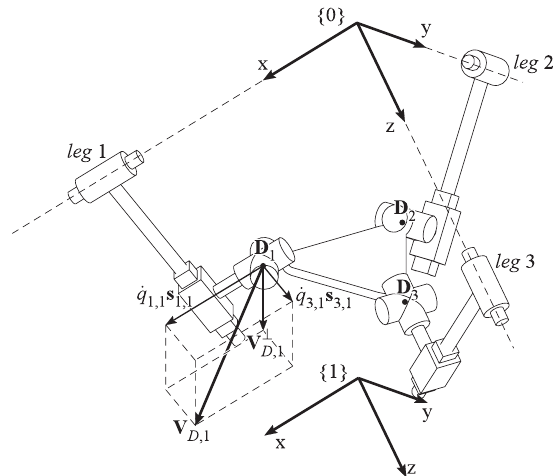
Figure 5. Velocity of attachment points between legs and moving